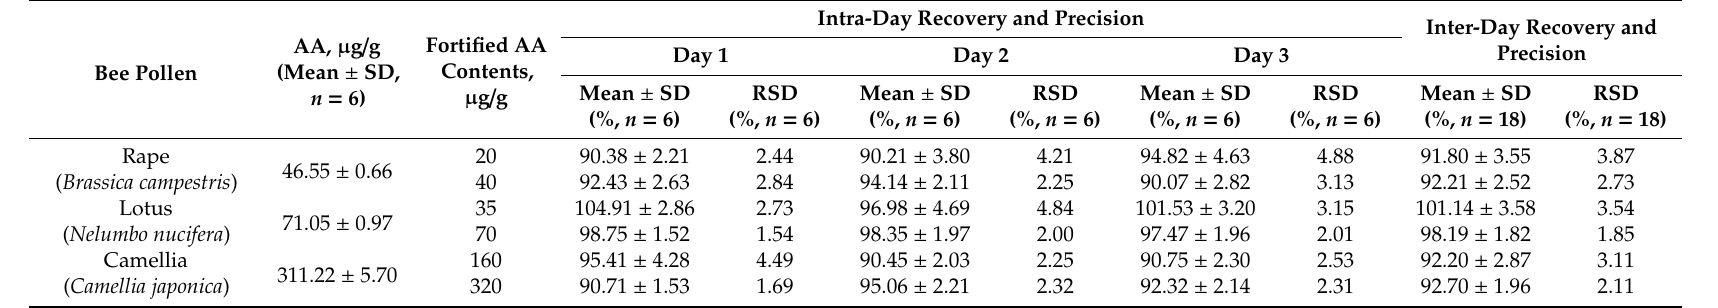
Table 1. The recovery and precision for AA at spiked bee pollen